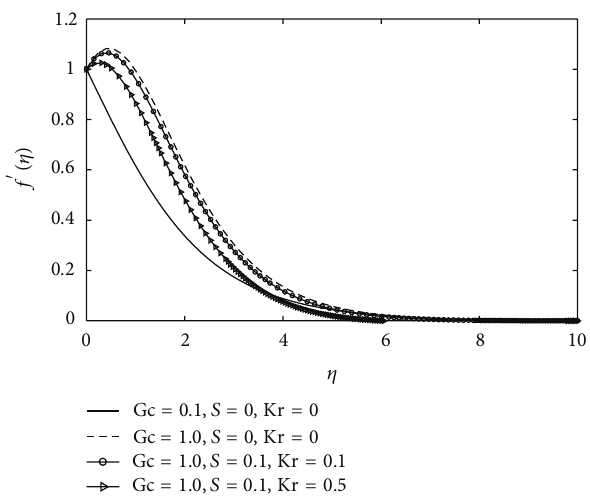
Figure 4: Velocity profiles for different values of Gc, 𝑆 , and Kr for Ha = 0.1 , Gr = 0.1 , Sc = 0.62 , Bi = 0.1 , Nc = 0.01 , and Pr = 0.72